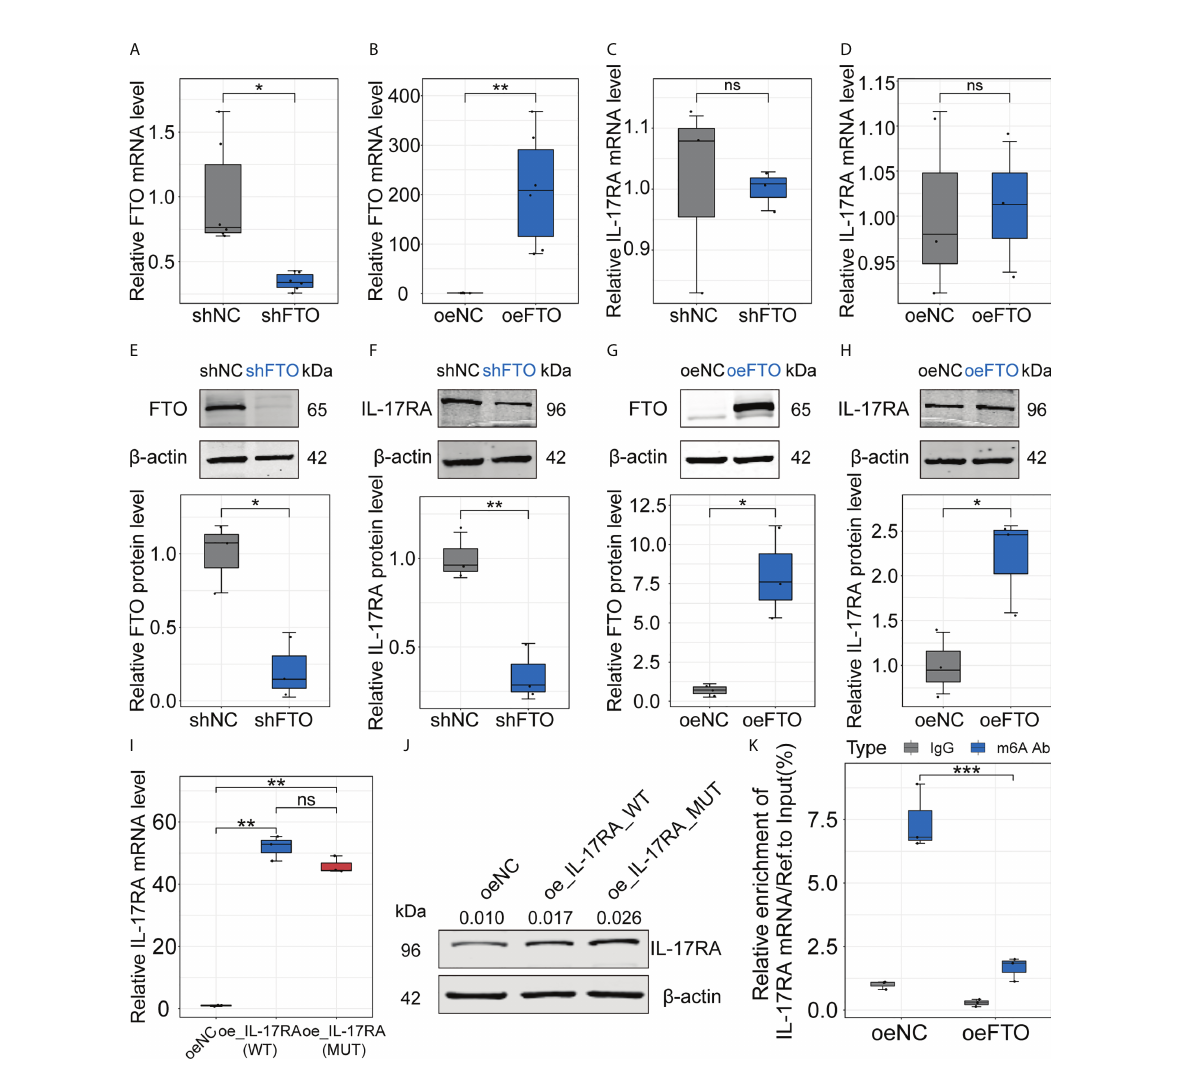
FIGURE 3 Regulation of FTO interferes protein level of IL-17RA in vitro . (A-D) . Relative FTO or IL-17RA mRNA level in Huh7 cells after FTO knockdown or overexpression. (E-H) . Relative FTO or IL-17RA protein level in Huh7 cells after FTO knockdown or overexpression. (I) . Relative IL-17RA mRNA level in Huh7 cells after IL-17RA_WT or IL-17RA_MUT overexpression. (J) . IL-17RA protein level in Huh7 cells after IL-17RA_WT or IL-17RA_MUT overexpression. (K) . Relative m6A enrichment of IL-17RA mRNA in Huh7 cells after FTO overexpression by m6A-RIP-qPCR. All experiments were repeated at least three times and expressed as the means ± SEM. ns, not signi fi cant; * p < 0.05; ** p < 0.01; *** p <